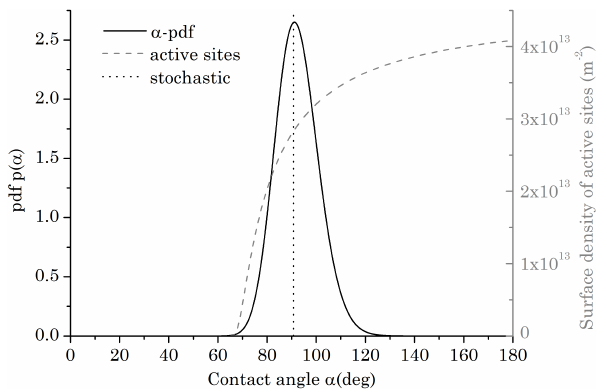
Fig. 6. Contact angle distribution on the particles.